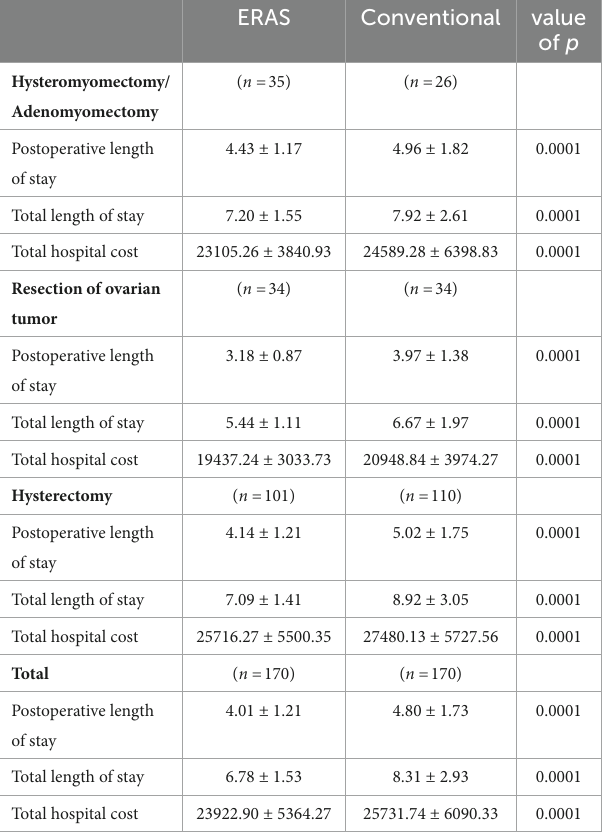
TABLE 3 Recovery time and cost between ERAS and conventional